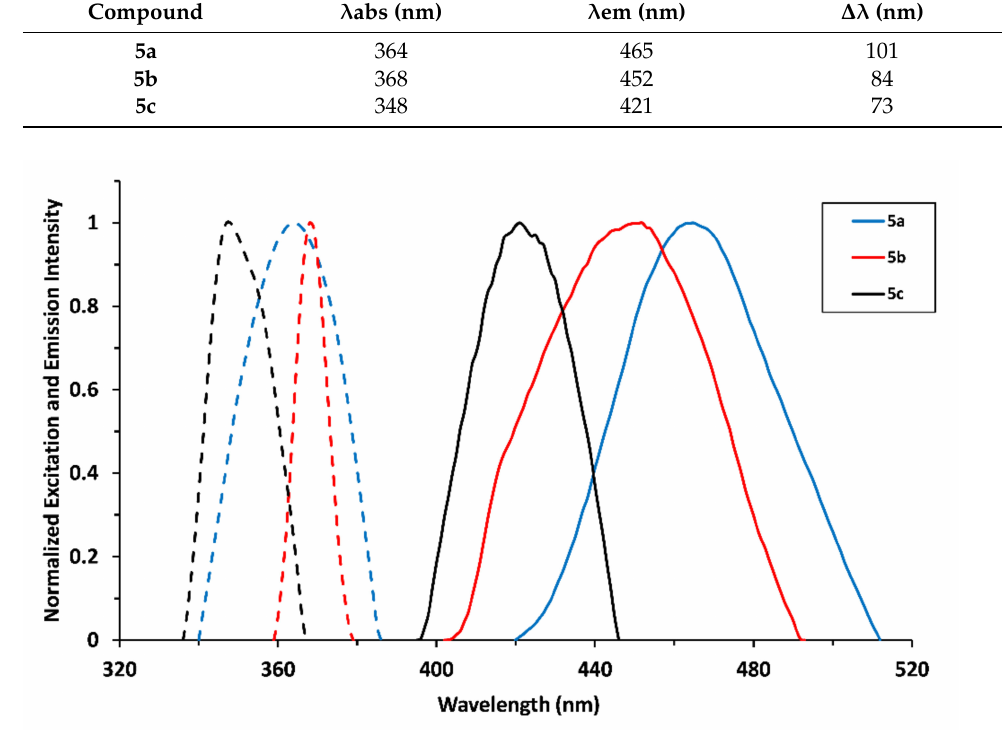
Figure 4. Normalized emission spectra of 5a–c in DMSO. 5a was recorded at 0.5 µ M, and 5b,c were recorded at 5 µ M. Excitation curves are displayed as dashed lines. All compounds were excited at their absorbance λ max